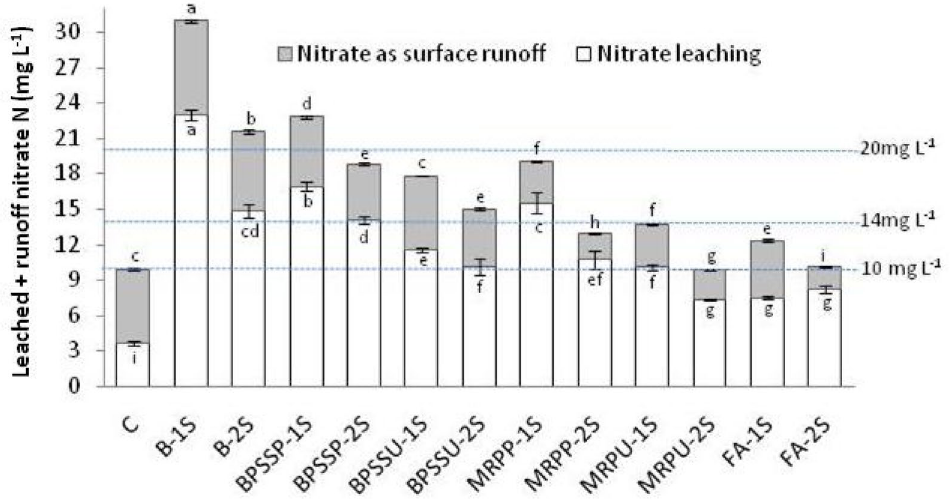
Figure 1. Nitrogen losses (as leaching and surface run off) and their cumulative pollution potential, as effected by various N input methods in saffron growing cold humid region of North West Himalayas (Maximum permissible limit (MPL), as per Environmental Protection Agency (EPA) guidelines, of Nitrate N in ground water/water bodies = 10 mg L −1 ; Negligible polluting potential (≤ 10 mg L −1 ); Low polluting potential